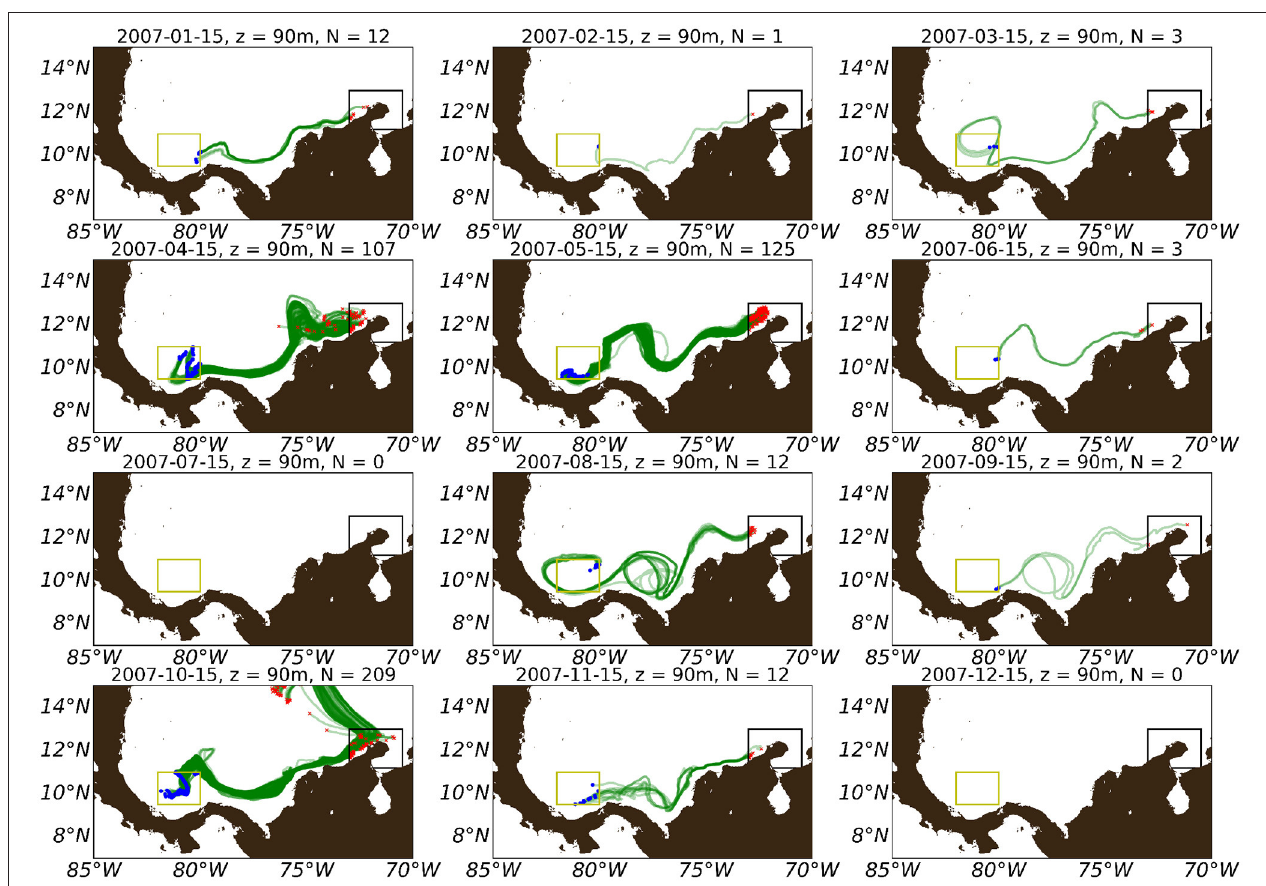
FIGURE 13 | Lagrangian trajectories of particles launched in the yellow box ( > 6,000 particles), within the Panama-Colombia Gyre. Pathways are computed forward in time during 90 days. Initial (final) positions of advected particles are denoted by blue (red) dots, respectively. Particles are deployed at the 15 th day of each month during year 2007 inside the yellow box at the same positions. Only those that cross at anytime the black box around La Guajira are depicted. Tracking is performed over HYCOM horizontal current velocities at a depth of